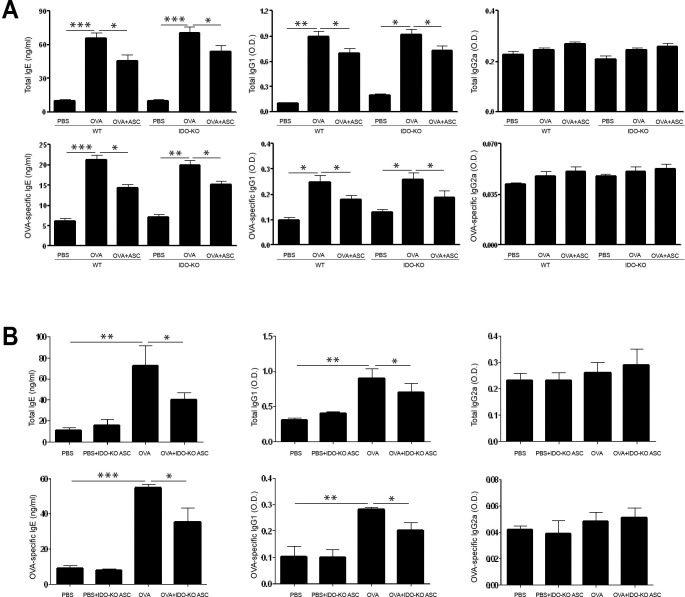
Effect of adipose-derived stem cells (ASCs) on serum levels of immunoglobulin.Systemic administration of ASCs (A) or ASCs derived from indoleamine 2, 3-dioxygenase (IDO)-knockout (KO) mice (B) resulted in a significant decrease in total IgE, total IgG1, OVA-specific IgE, and OVA-specific IgG1 in WT and IDO-KO asthmatic mice. Data are expressed as the mean ± SEM of four independent experiments performed in triplicate. *
p<0.05, **
p≤0.005, ***
p≤0.001.